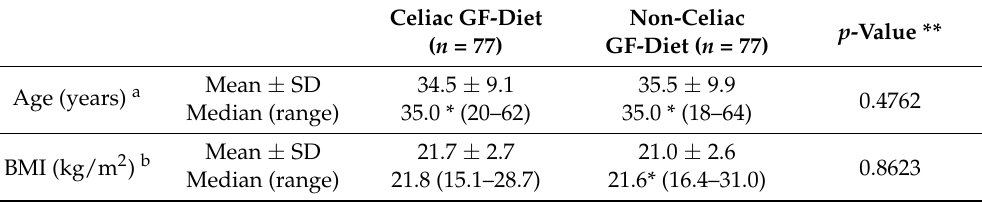
Table 1. Characteristics of the age and body mass index of participants stratified by study groups.